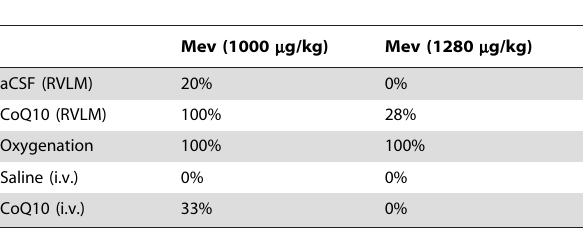
Table 1. Probability of resumption of spontaneous circulation after cardiac arrest induced by intravenous administration of